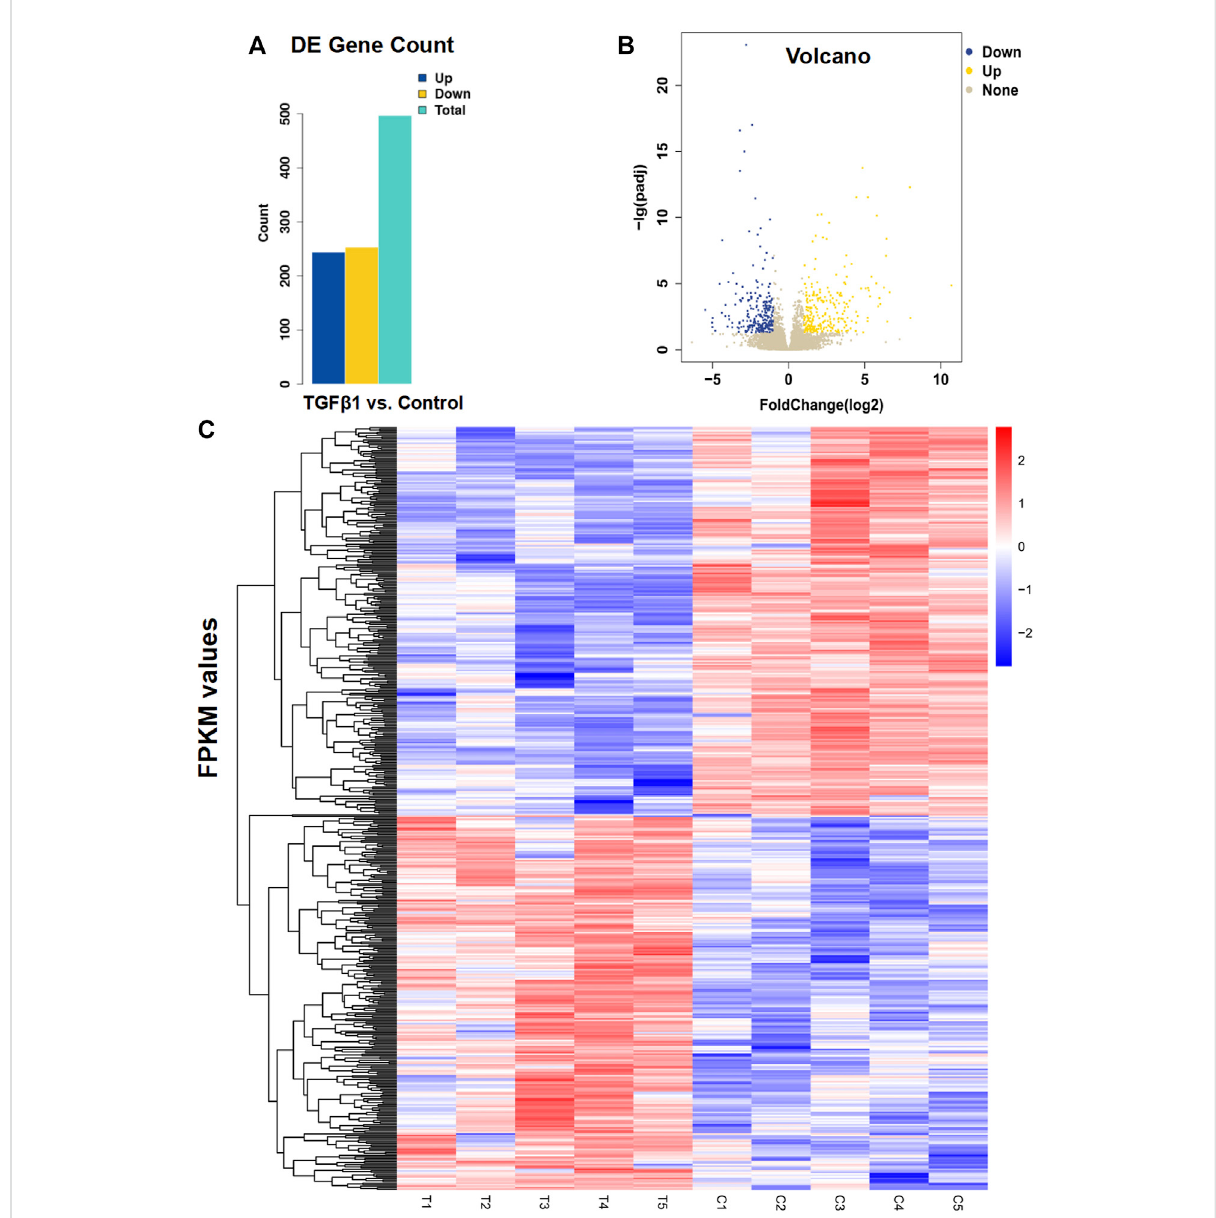
FIGURE 2 Analysis of differential gene expression in PrSCs stimulated with and without TGF β 1. (A) Results of differentially expressed genes (DEGs) were counted according to the screening criteria of |log2 Fold change| ≥ 1 and q < 0.05. Of the 497 differential genes detected in PrSCs with TGF β 1 stimulation, 244 genes were upregulated and 253 genes were downregulated. T_C means TGF β 1 treatment versus control. (B) Volcano diagram showed signi fi cantly DEGs in PrSCs stimulated with and without TGF β 1. Yellow spots represented upregulated genes, and blue spots represented downregulated genes. Gray spots indicated genes that were not differentially expressed. (C) Heatmap plot of all 497 DEGs in fi ve PrSCs with and without TGF β 1 treatment. The legend color bar on the right side indicated the relation between FPKM-scaled expression values and colors, and the colors were balanced to ensure that the white color represented a zero value. C1, C2, C3, C4, and C5 in the heatmap mean PrSCs without TGF β 1 treatment (control). T1, T2, T3, T4, and T5 in the heatmap mean PrSCs with TGF β 1